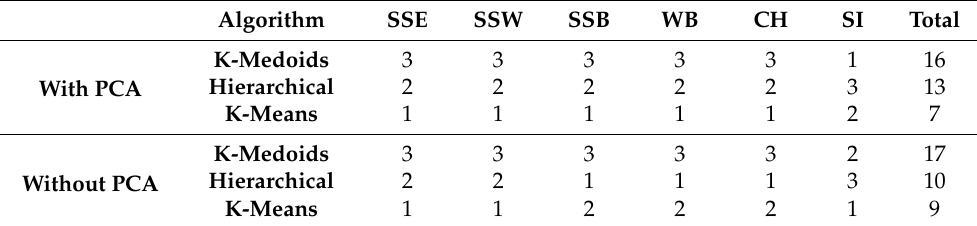
Table 3. Ranking using Borda count method considering results from Hierarchical, K-Means and K-Medoids with and without PCA